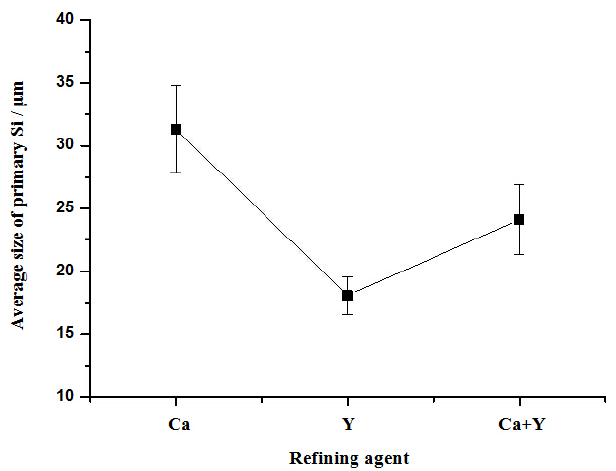
Figure 2. Variation of average size of primary Si in Al–18Si alloys with different melt treatments.